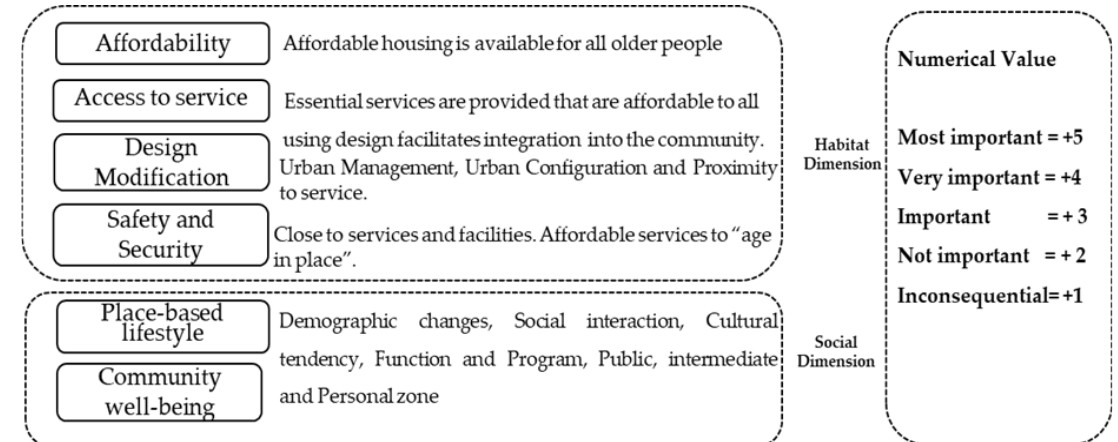
Figure 4. Dimensional criteria and assessment value.